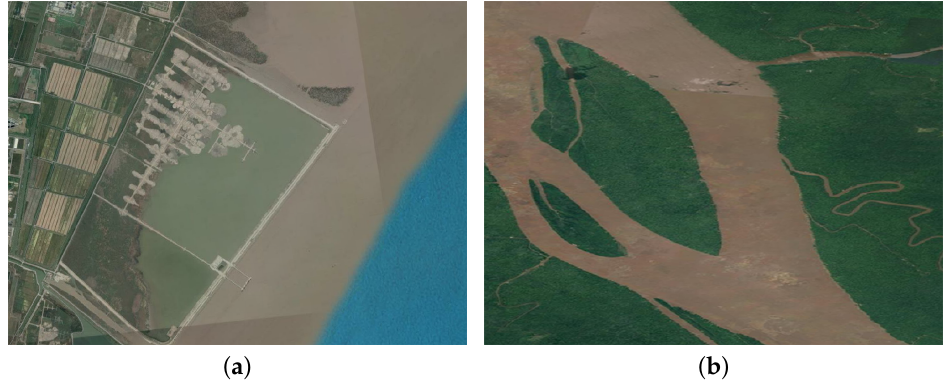
Figure 4. Optical remote sensing image of experimental areas (provided by Google Earth). ( a ) Scene 1 corresponding to data 1. ( b ) Scene 2 corresponding to data 2. The size of scene 1 is 8673 m (vertical direction) × 8867 m (horizontal direction). The size of scene 2 is 19,228 m (vertical direction) × 4935 m (horizontal